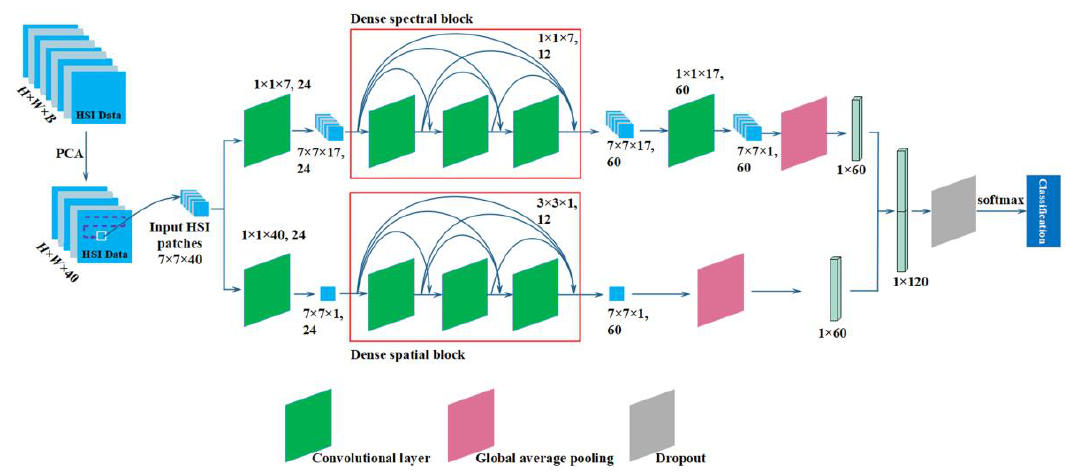
Figure 8. The architecture of the proposed hybrid DenseNet model.